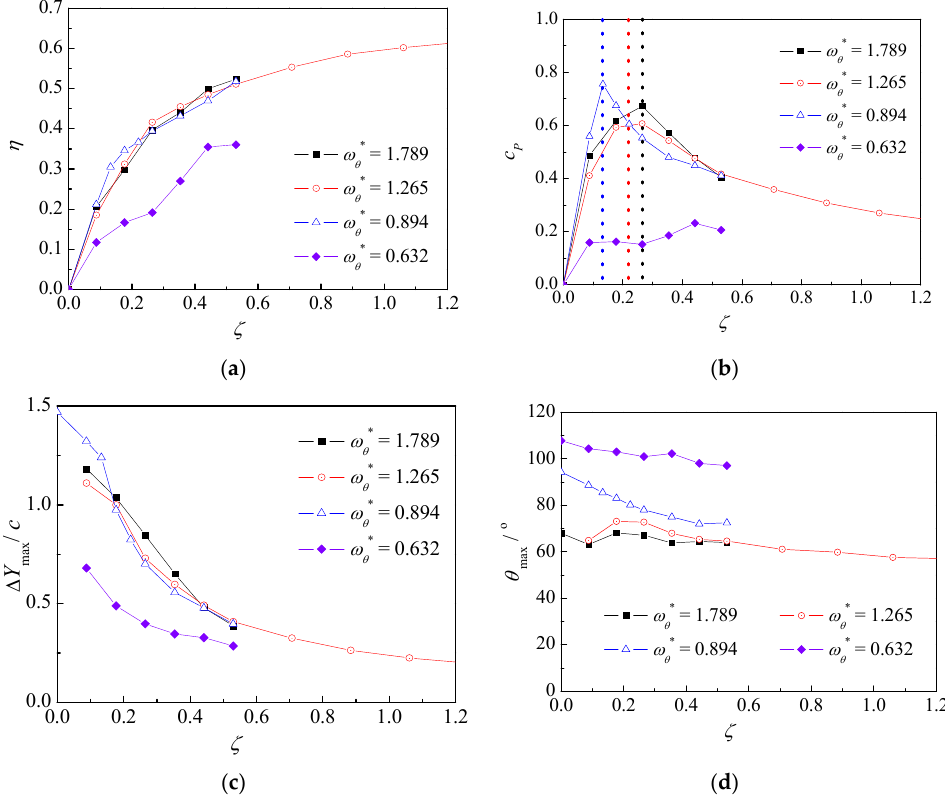
Figure 14. Foil performance parameters as a function of the damping coefficient ( ζ ) for various values of the pitching motion frequency ratio ( ω θ *). ( a ) Efficiency η ; ( b ) power coefficient c p ; ( c ) heave amplitude ∆ Y max / c ; ( d ) pitch amplitude ∆ θ max . (The three dotted lines in ( b ) representing the peak position of power coefficient c p with different frequency ratio)